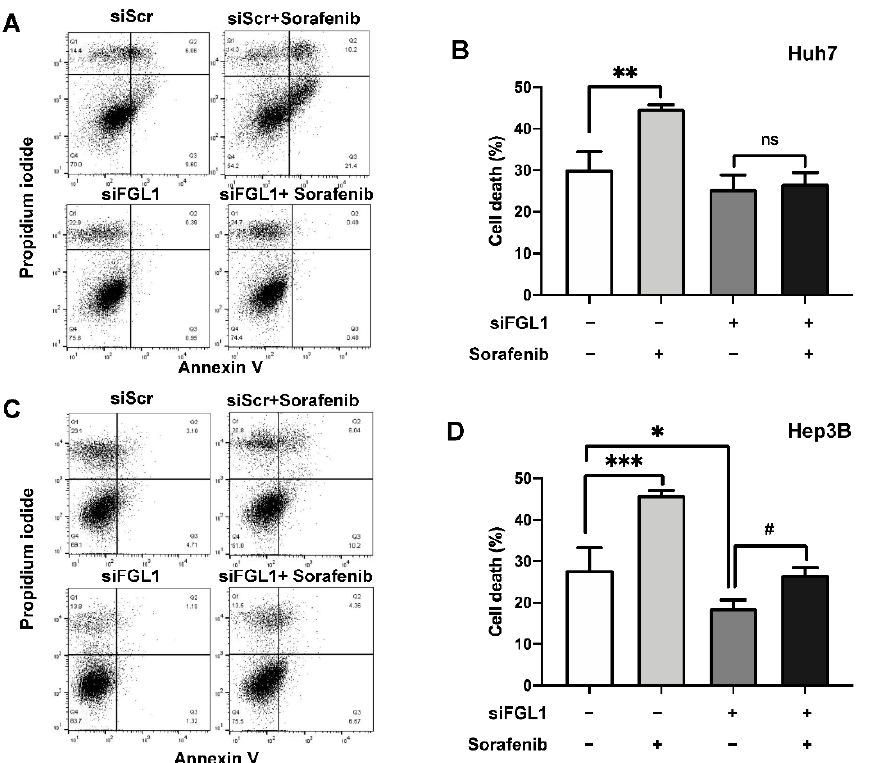
Figure 5. Effect of FGL1 knockdown on sorafenib-induced cell death in Huh7 and Hep3B cell lines. Flow cytometry results of Huh7 ( A , B ) and Hep3B ( C , D ) cells are shown. The cell death percentage was estimated using the sum of the upper left, upper right, and lower right quadrants in each dot plot. The graphs present percentage of cell death. All values are presented as the mean ± standard deviation of three independent experiments. * p < 0.05, ** p < 0.01, and *** p < 0.001, significantly different from scrambled siRNA-treated cells; # p < 0.05, significantly different from FGL1 siRNA- treated cells. siFGL1 ( − ), treated with siScr; Sorafenib ( − ), treated with vehicle (DMSO); siScr, scrambled siRNA; siFGL1, FGL1 siRNA.